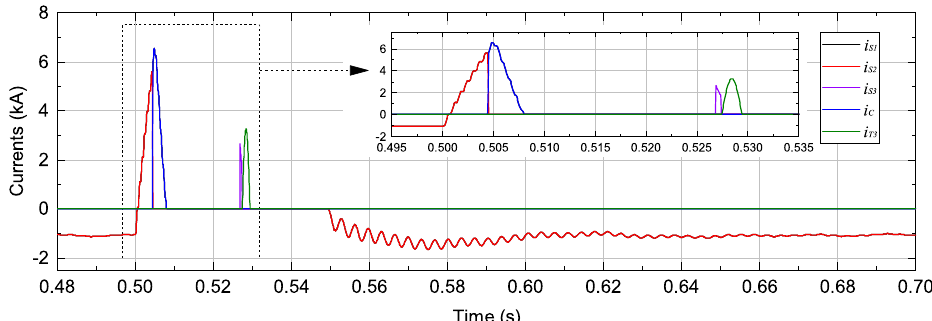
Figure 10. Overall currents on the switches of HCB 3.